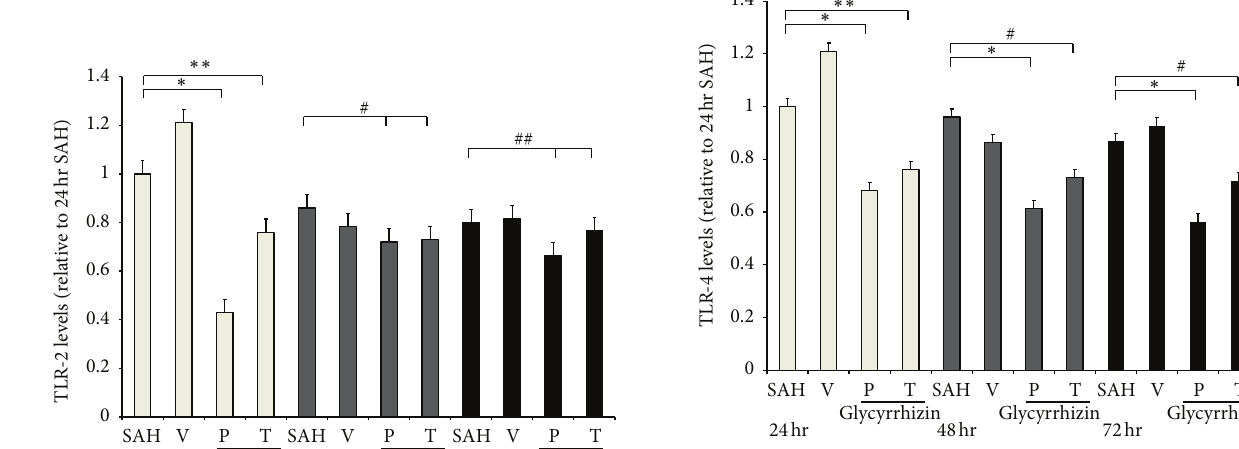
Figure 5: Time course expression of tissue Toll-like receptor 4 (TLR-4) (Western blot). ∗ 𝑃 < 0.01 : precondition with glycyrrhizin (24, 48, and 72 hr, resp.) groups, and ∗∗ : 𝑃 < 0.01 , treatment with glycyrrhizin (24hr) compared with the SAH groups. # : 𝑃 > 0.05 compared with the SAH group. All groups are equal to those publicized in Figure